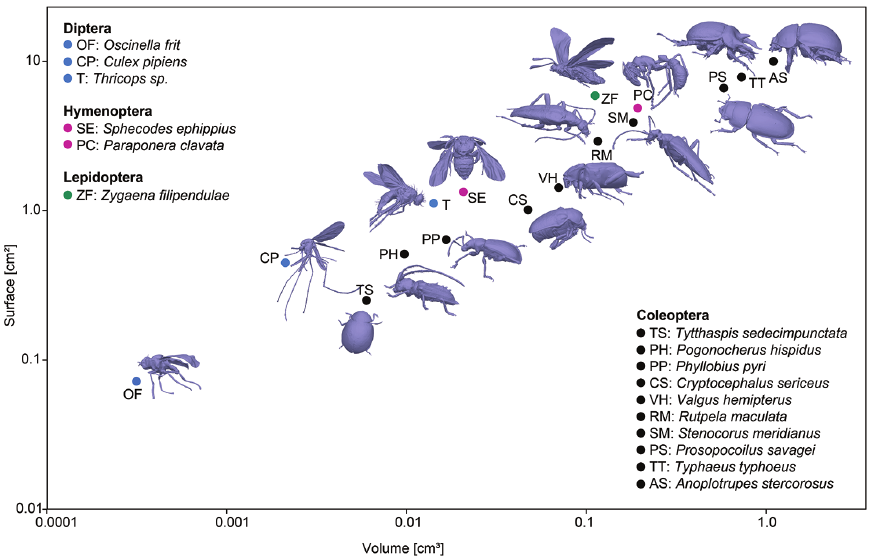
Figure 17. Relation of surface area and volume for all insect species presented here. While the dipteran, hymenopteran and lepidopteran species had their wings unfolded, all beetles had the wings folded under- neath their elytra. Models are not to